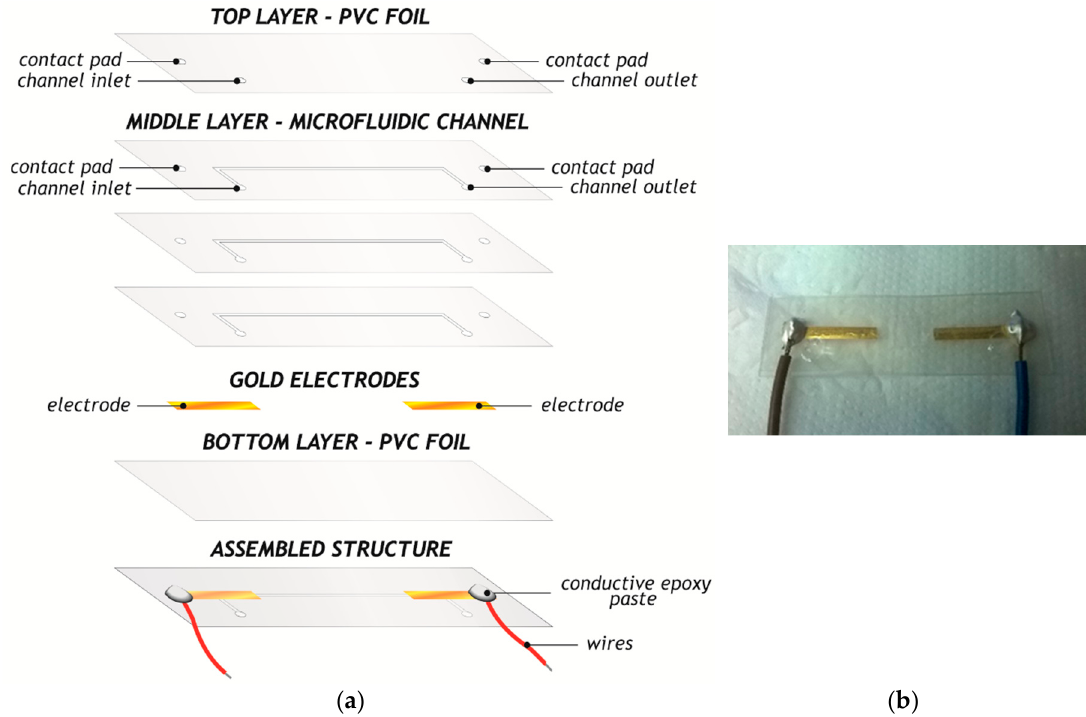
Figure 8. ( a ) Design of all layers of the memristive structure: bottom—PVC layer with gold electrodes, middle layer—microfluidic channel, top layer—for inlet, outlet, and electrical contact pads, ( b ) fabricated microfluidic memristor.